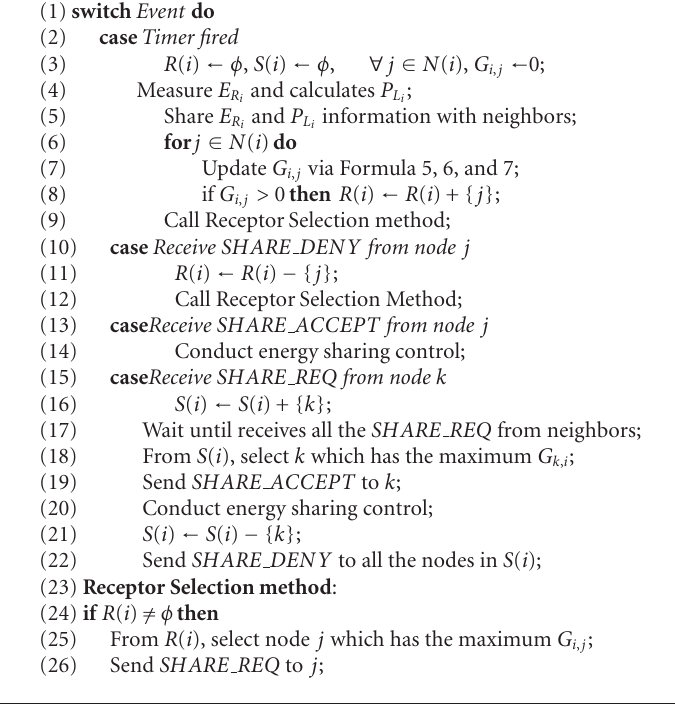
Algorithm 2: Network layer energy sharing